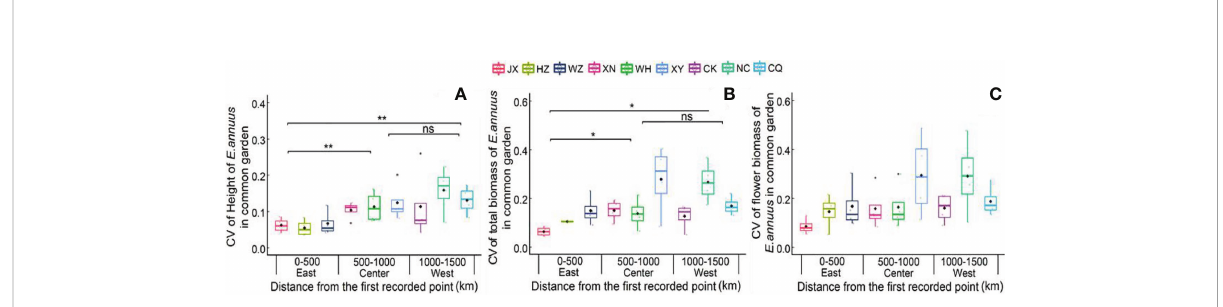
FIGURE 2 Coef fi cient of variation (CV) of height (A) , total biomass (B) and fl ower biomass (C) of E. annuus geographic populations of common garden experiments in different regions. Mean ± SE were given. The signi fi cance levels are: **p < 0.01, *p < 0.05, and ns, p > 0.05. JX, Jiaxing; HZ, Hangzhou; WZ, Wenzhou; N, Xianning; WH, Wuhan; XY, Xiangyang; CK, Chengkou; NC, Nanchuan; CQ,